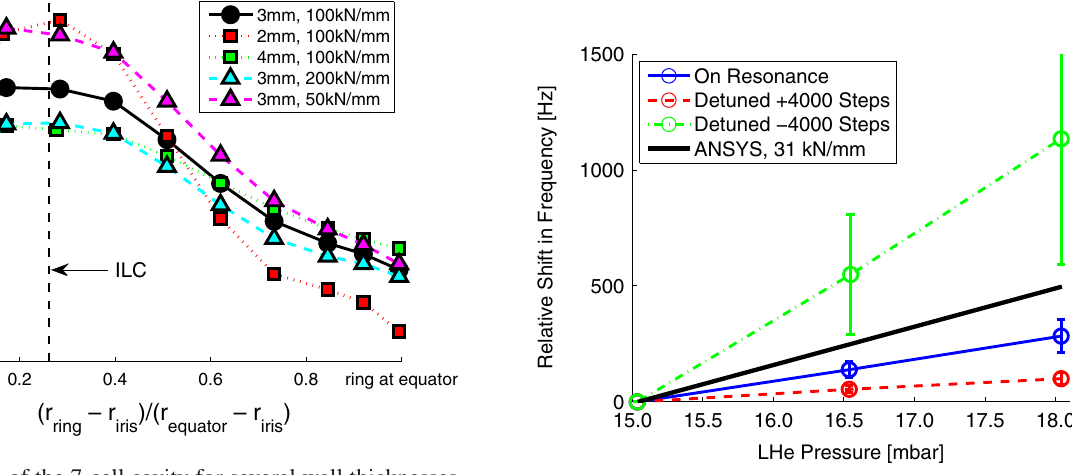
FIG. 7. Measured (cid:1) f versus (cid:1) p of the 2-cell cavities for different tuner positions. The prediction from ANSYS simulations (cid:2) r Þ = is also shown, which assumes the stiffness of the tuner is ring iris 31 kN = mm